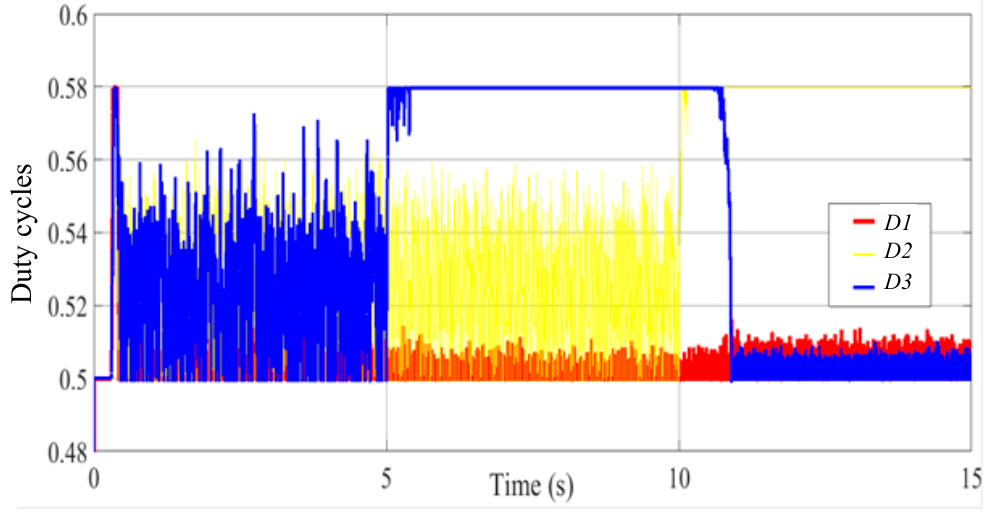
Figure 11. The three duty cycles to the IBC.